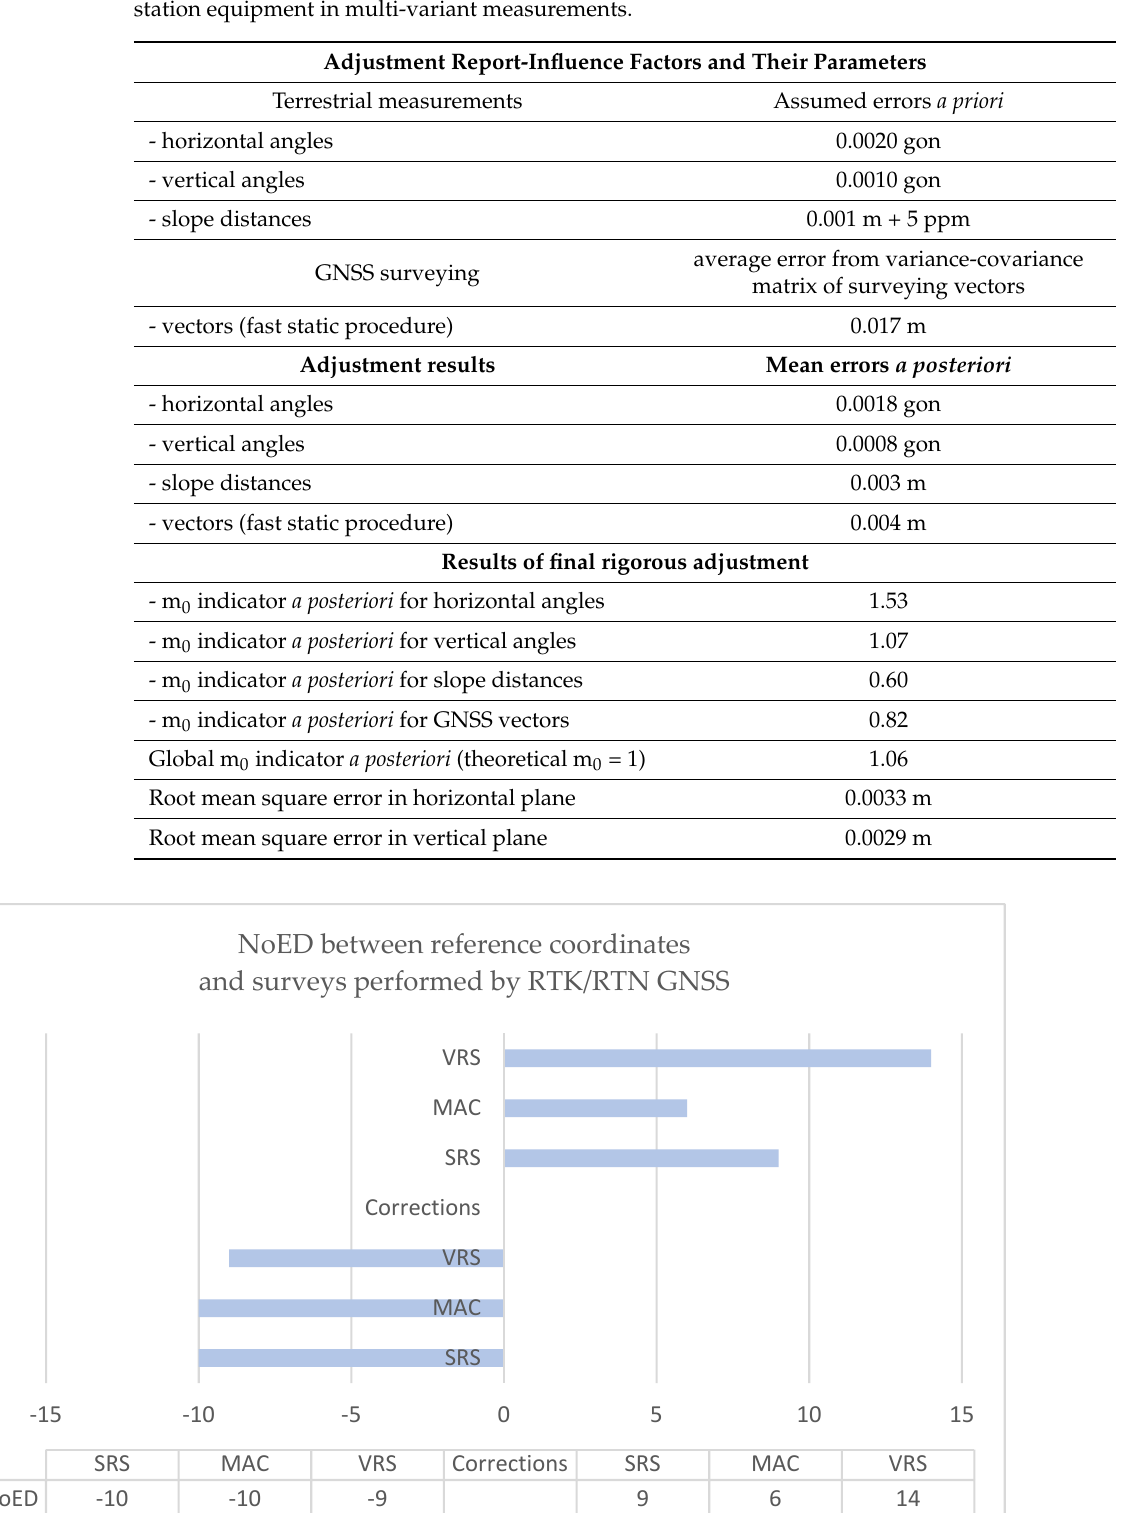
Table 4. Results of rigorous adjustment of terrestrial and satellite surveys performed using smart station equipment in multi-variant measurements.